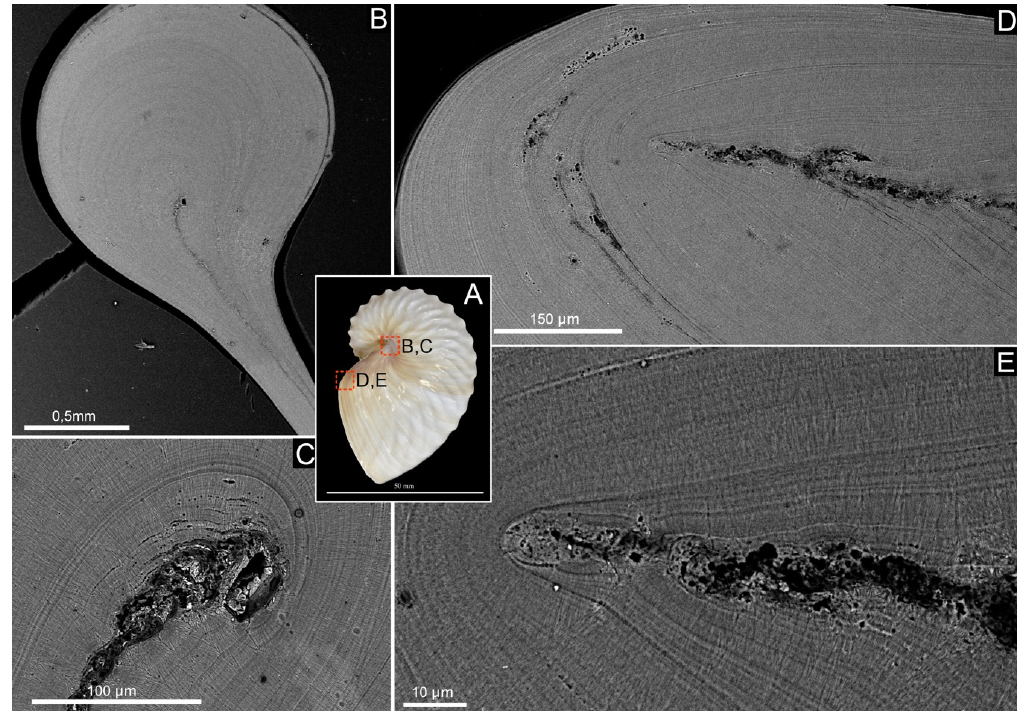
Figure 3. Shell microstructure of Argonauta hians . ( A ) Lateral view of the shell illustrating the two di ff erent locations of the following pictures. ( B ) General view of the enrolment axis of the shell. ( C ) Magnification (back-scattered electron mode) of the birth of the central core wrapped by the fibrous calcite. ( D ) General view of the aperture of the shell, on the dorsal side, showing the edge of the central “core” and the calcitic material surrounding it. ( E ) Close-up view of the edge of the central core, showing that this layer is sandwiched, on either side, by a calcite bevel and finally wrapped in a continuous layer of calcite.